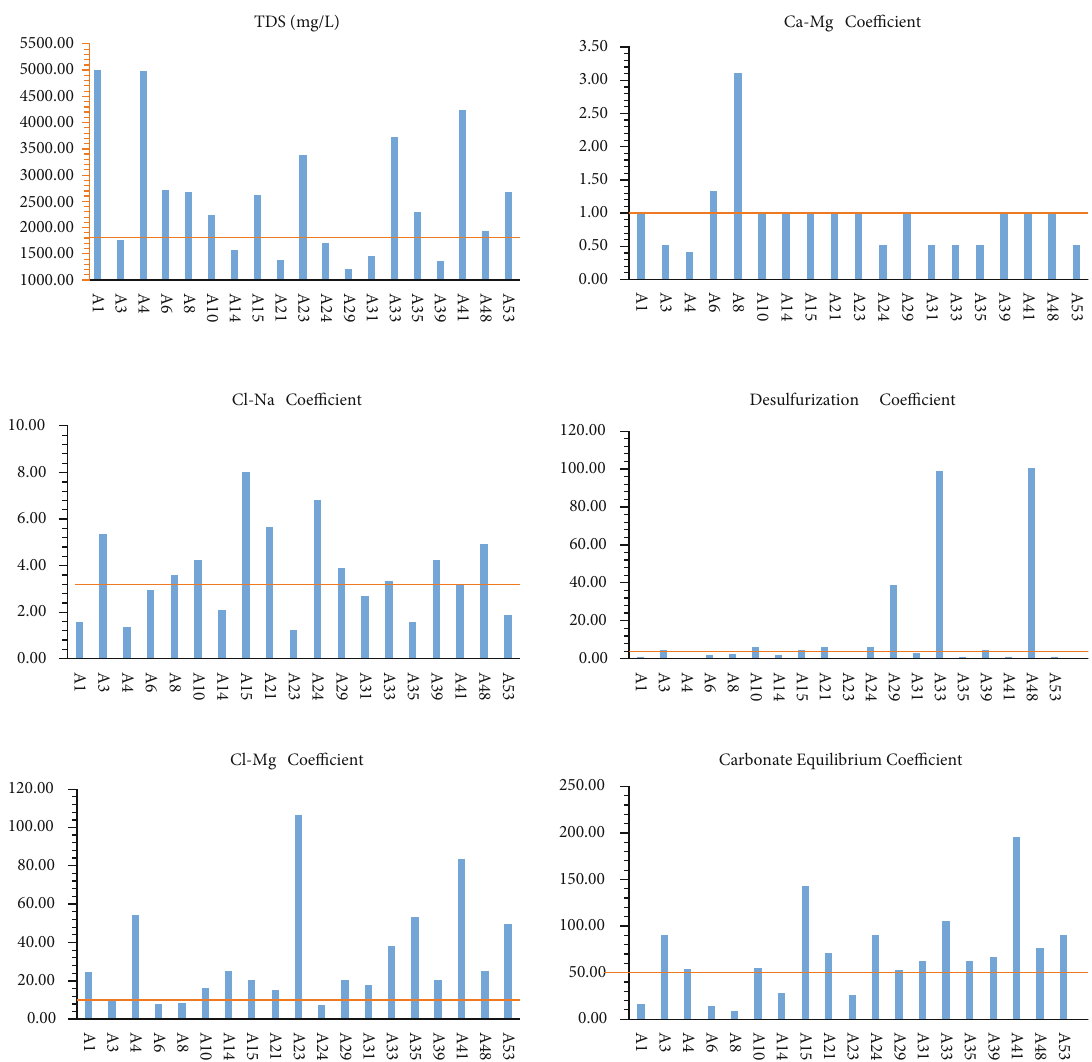
Figure 6: Geochemical parameters of groundwater in coal